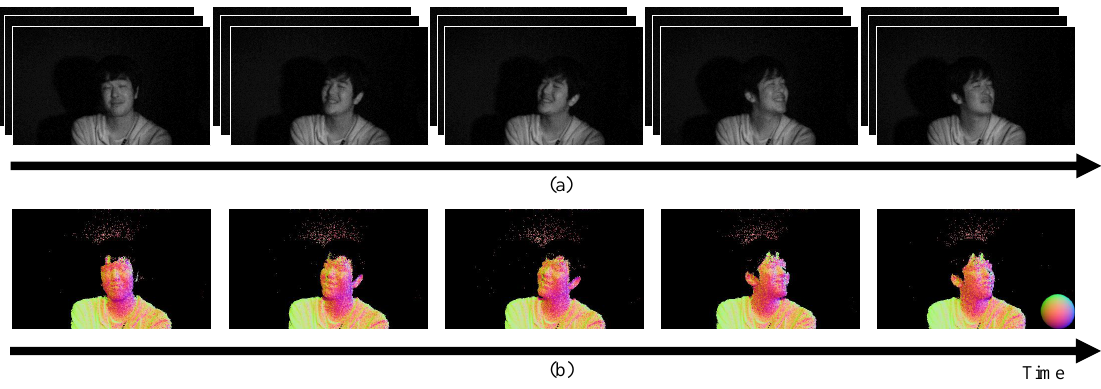
Figure 11. Results obtained using the photometric stereo method for a dynamic scene composed of a facial expression. ( a ) shows the images that were captured using the multi-tap CMOS image sensor, and ( b ) shows the normal maps that were estimated based on these images. We were able to estimate the surface normals of the facial expressions. To make the results easier to see, we modulated the brightness of the captured images to be 800% brighter than the original